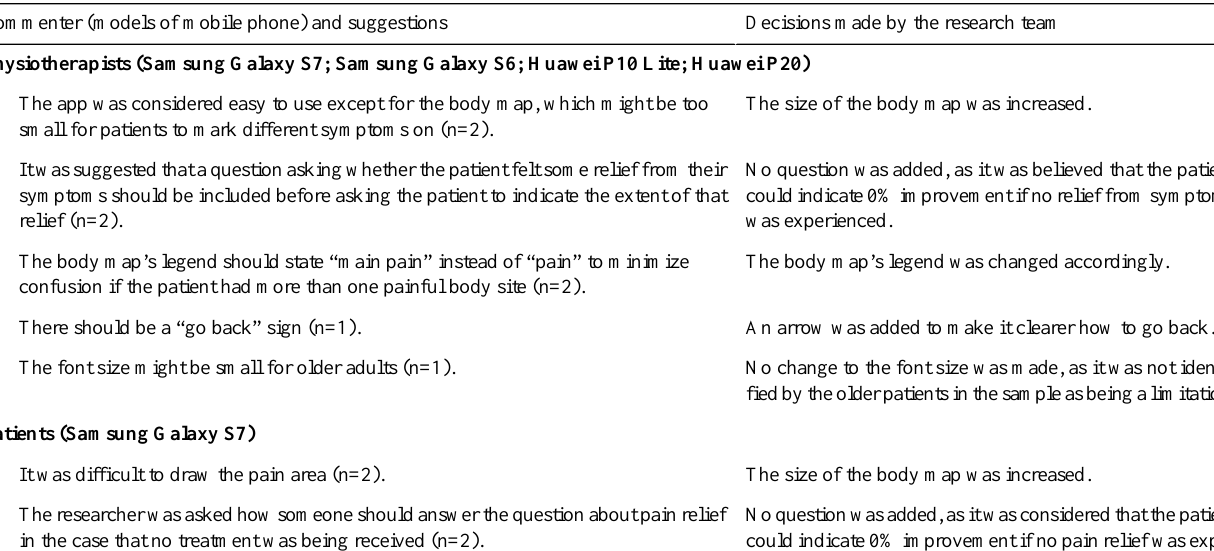
Decisions made by the research teamCommenter (models of mobile phone) and suggestions